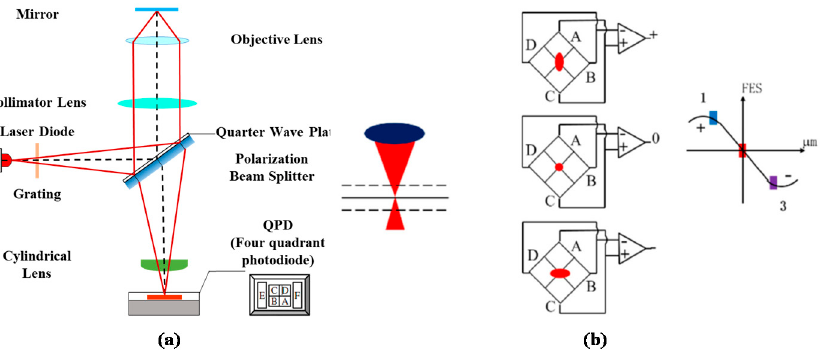
Figure 2. FES: ( a ) structure schematic and ( b ) sensing principle. Reprinted with permission from Ref. [26]. Copyright 2019 Springer Nature.